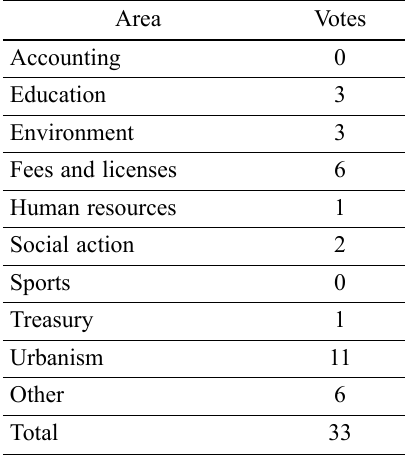
Table 8. Areas of e-government activity